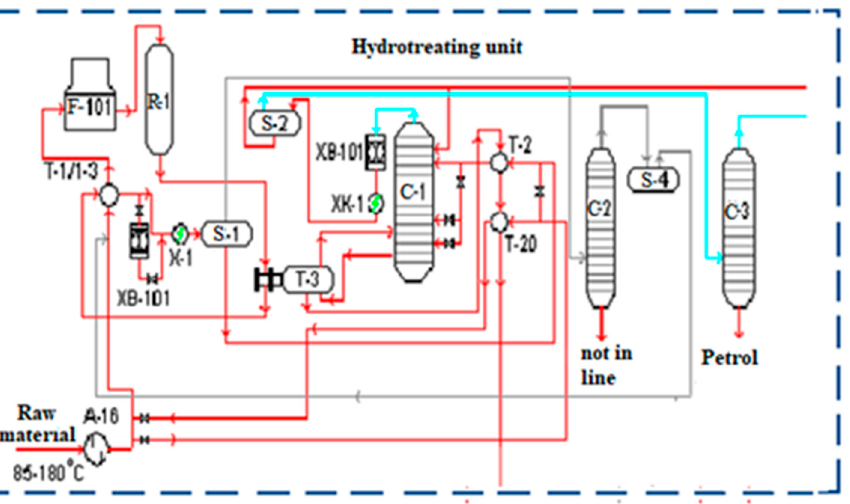
Figure 1. Technological scheme of hydrotreating unit at the catalytic reforming unit of the Atyrau refinery.